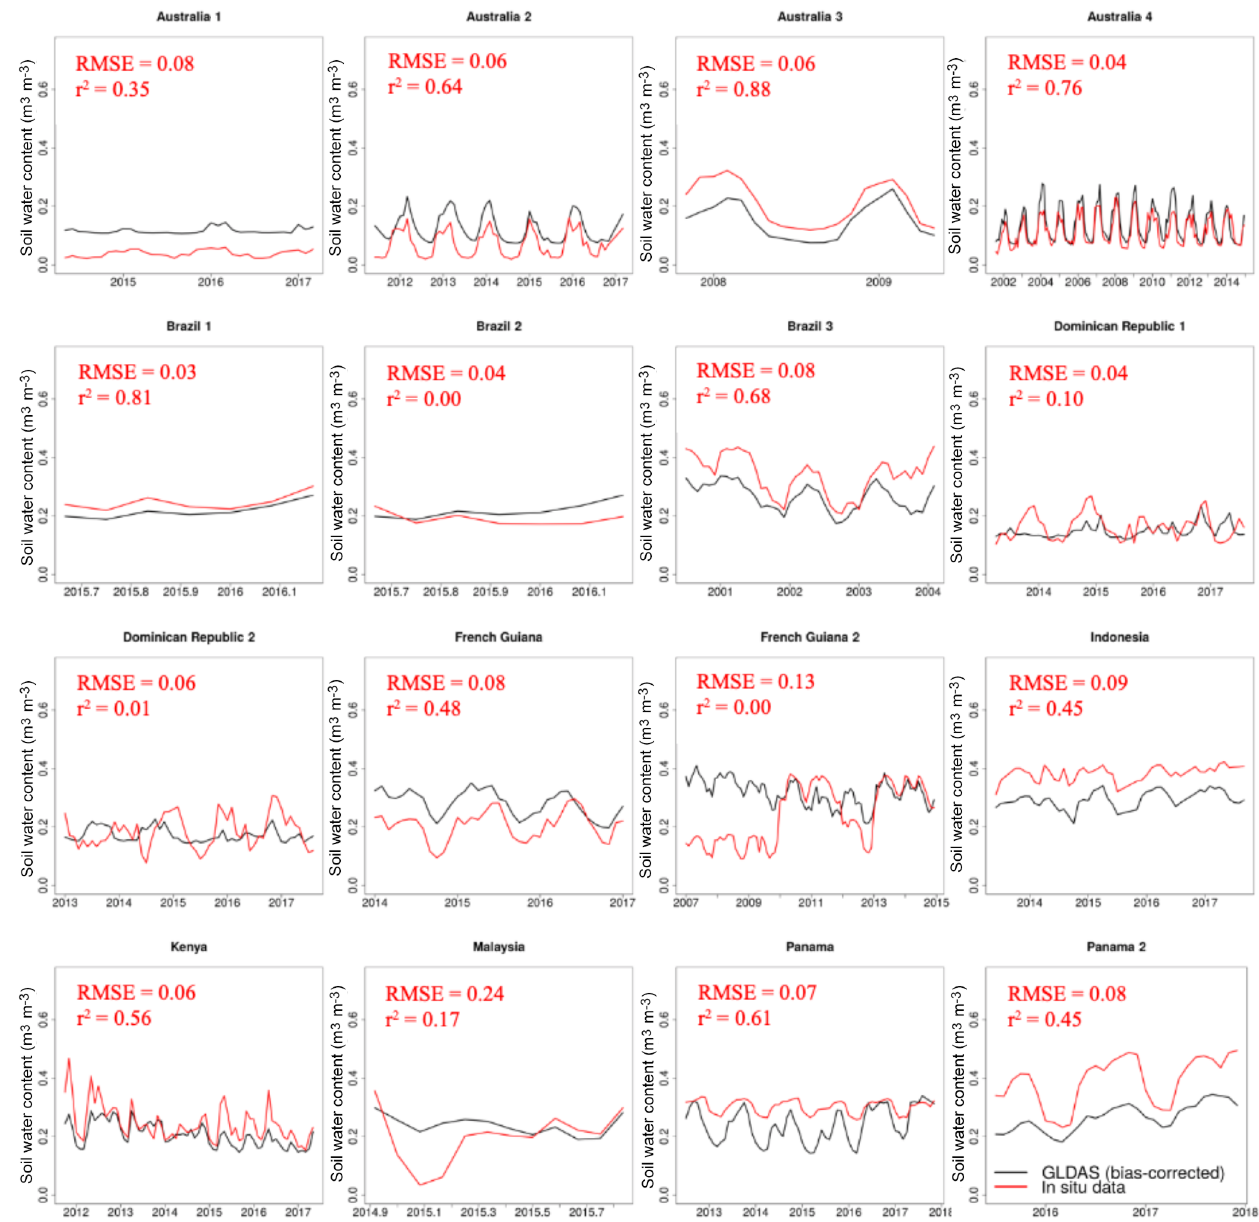
Figure 4. Bias-corrected estimate from GLDAS (black line) and in situ observation (red line) of soil water content for 16 individual locations in the humid tropics. RMSE and r 2 coefficient of determination for each location are also